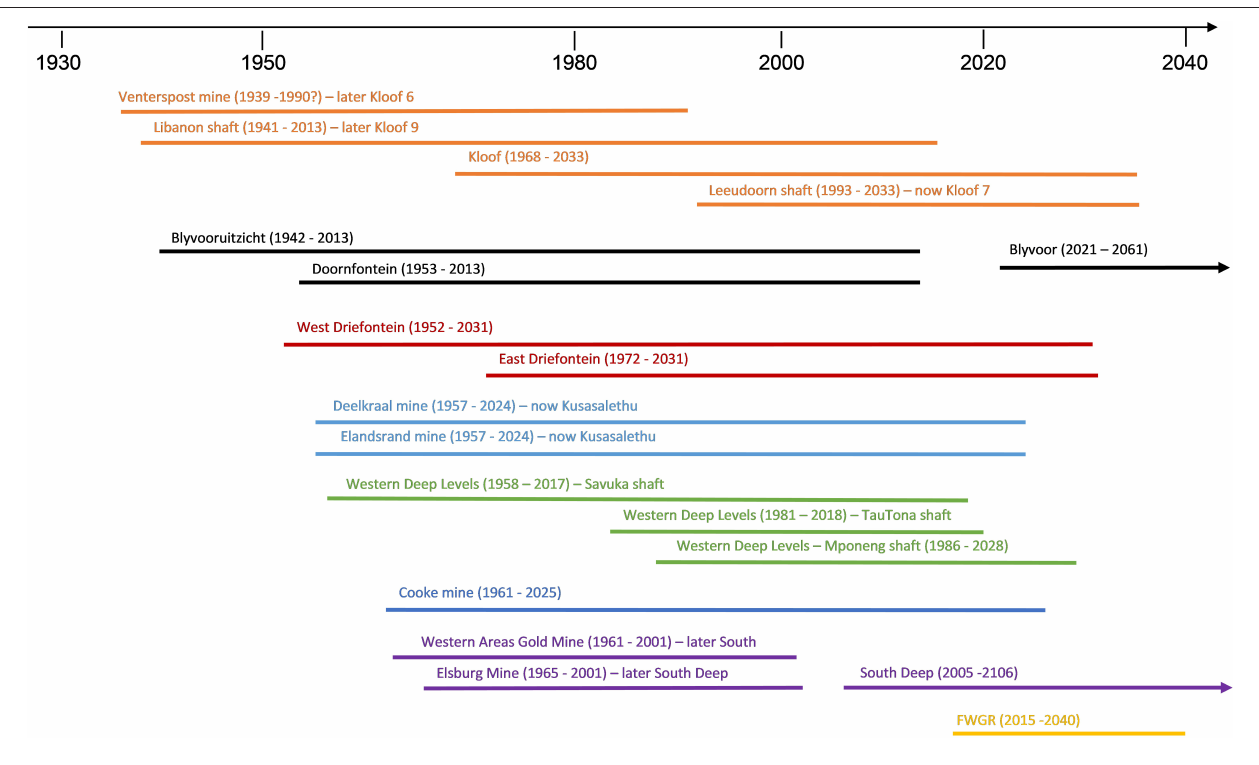
FIGURE 2 | Timeline of gold mines operating in the West Wits goldfield.